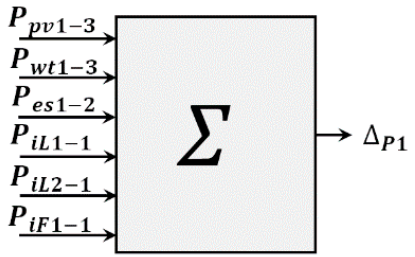
Figure 7. Block diagram of the model of the DC bus 1.